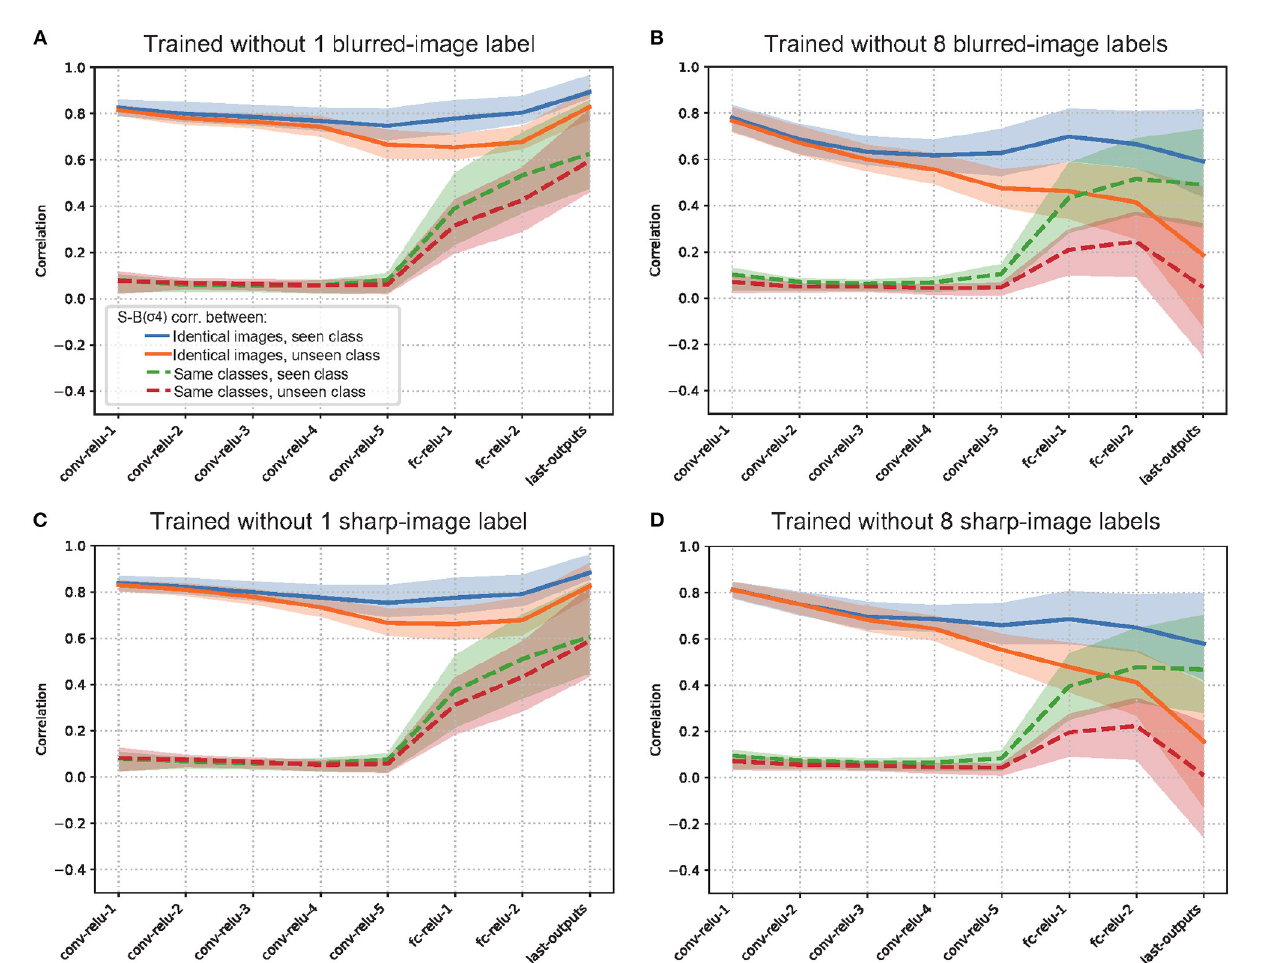
FIGURE7 Representational similarity analysis for zero-shot learning test when (A) one blurred-image label, (B) eight blurred-image labels, (C) one sharp-image label, or (D) eight sharp-image labels is/are excluded from the training set. Test set was blurred images for (A, B) , and sharp images for (C, D) . The results suggest the shared representation acquired by blur training can be reused, at least partially, to recognize an unseen object